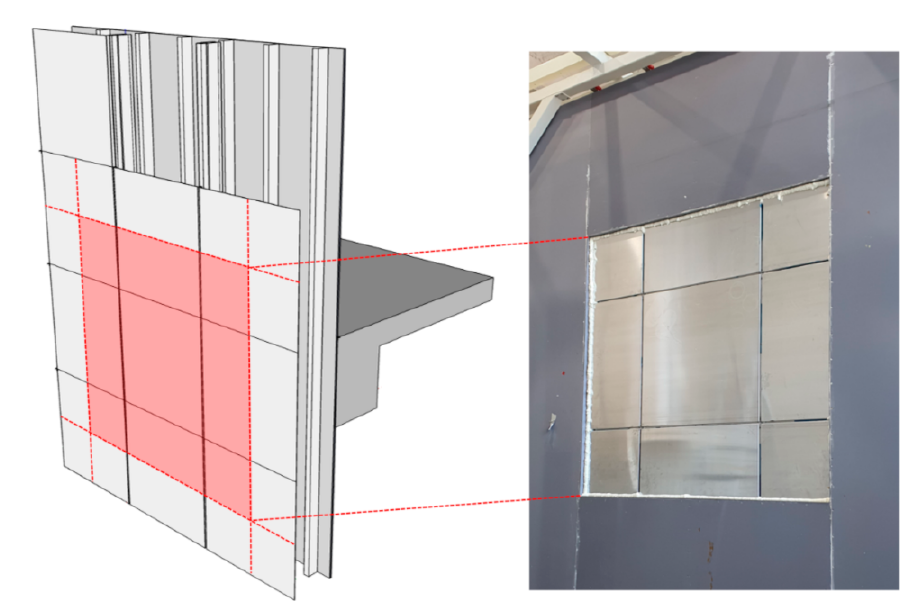
Figure 10. Location of cut-off planes for mock-up test.